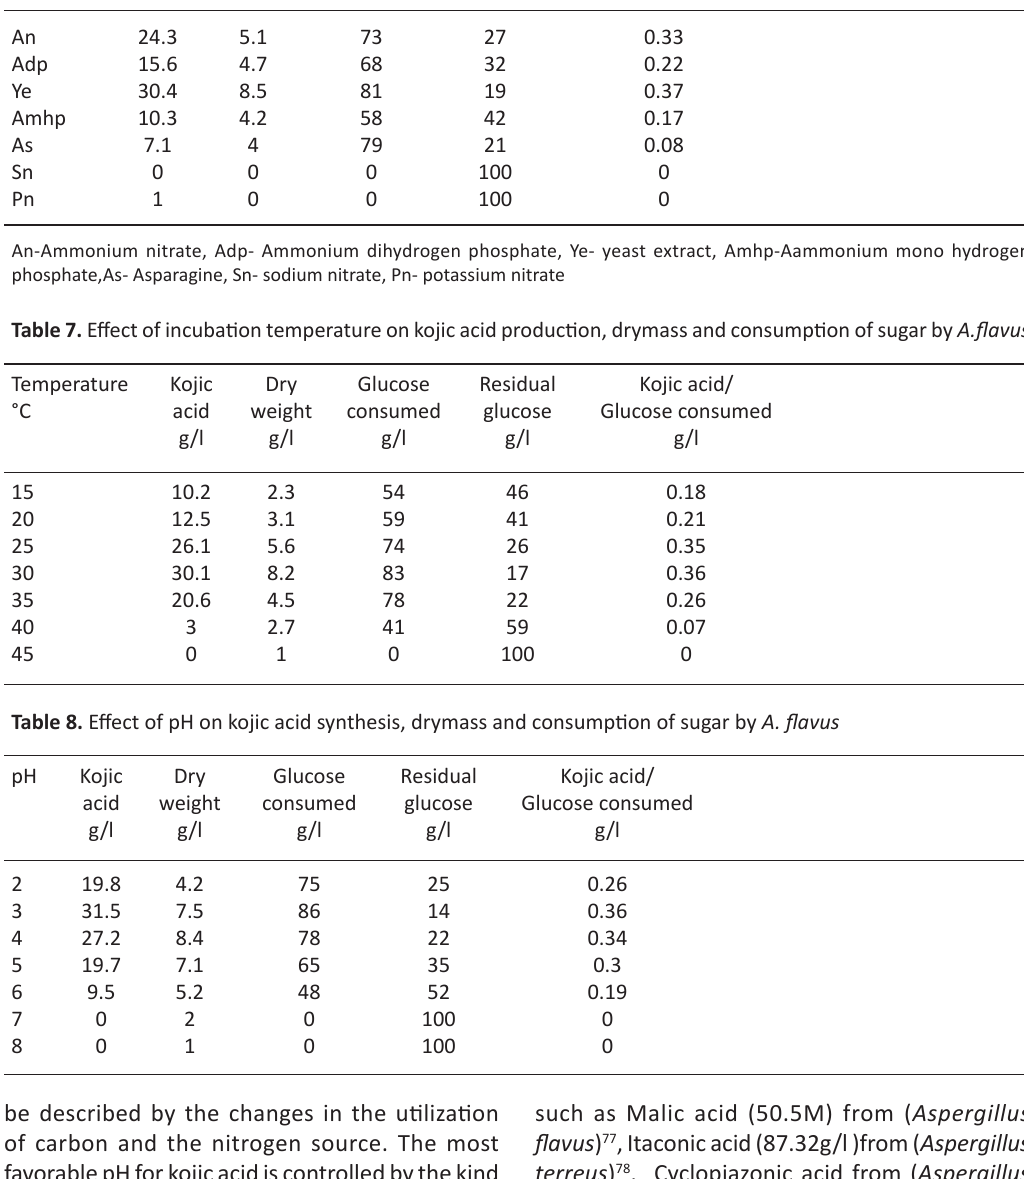
Table 6. Effect of different nitrogen source on synthesis of kojic acid drymass and consumption of sugar by A.flavus Nitrogen Kojic Dry Glucose Residual Kojic acid/ source acid